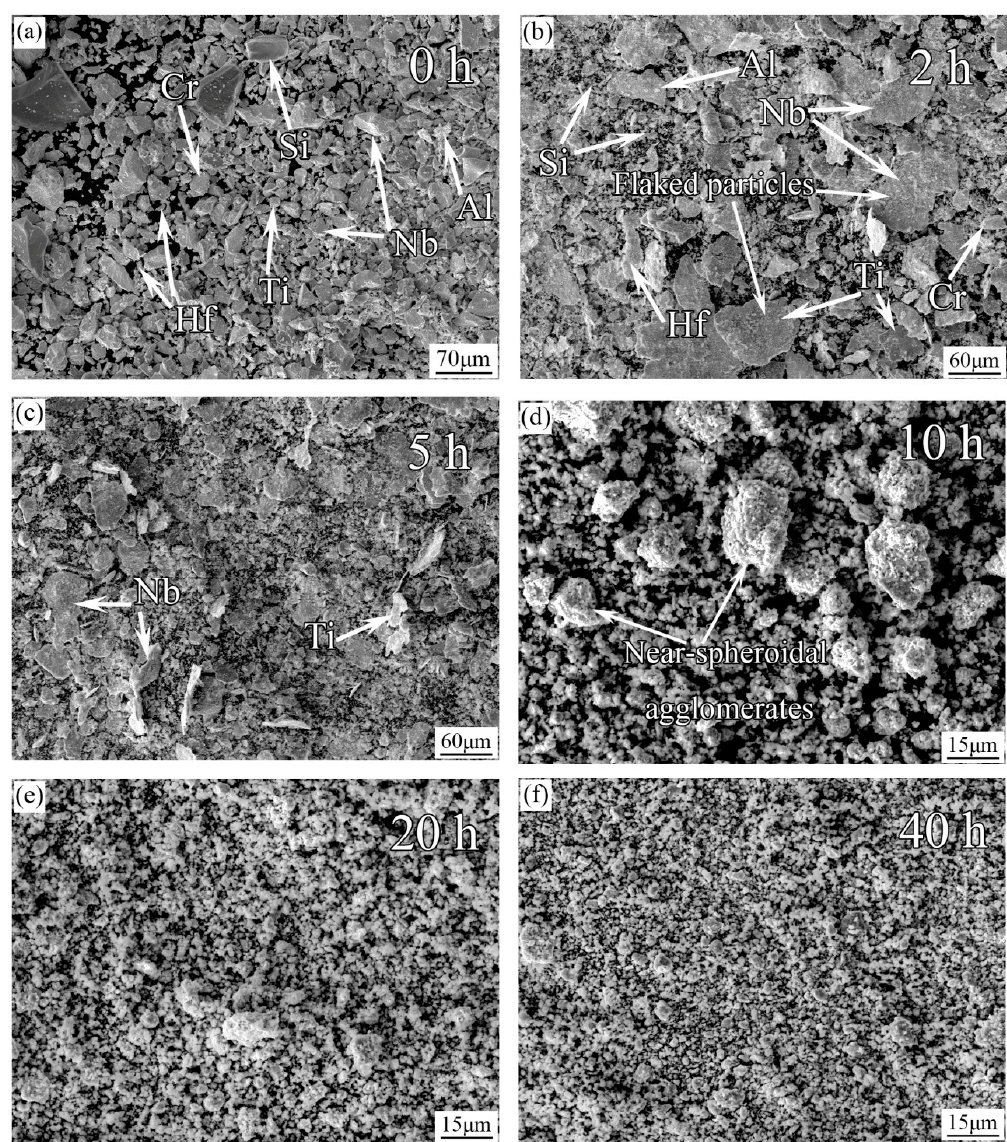
Figure 1. SEM images of the powders after ball milling for different times at 500 rpm: ( a ) 0 h; ( b ) 2 h; ( c ) 5 h; ( d ) 10 h; ( e ) 20 h; and ( f ) 40 h.